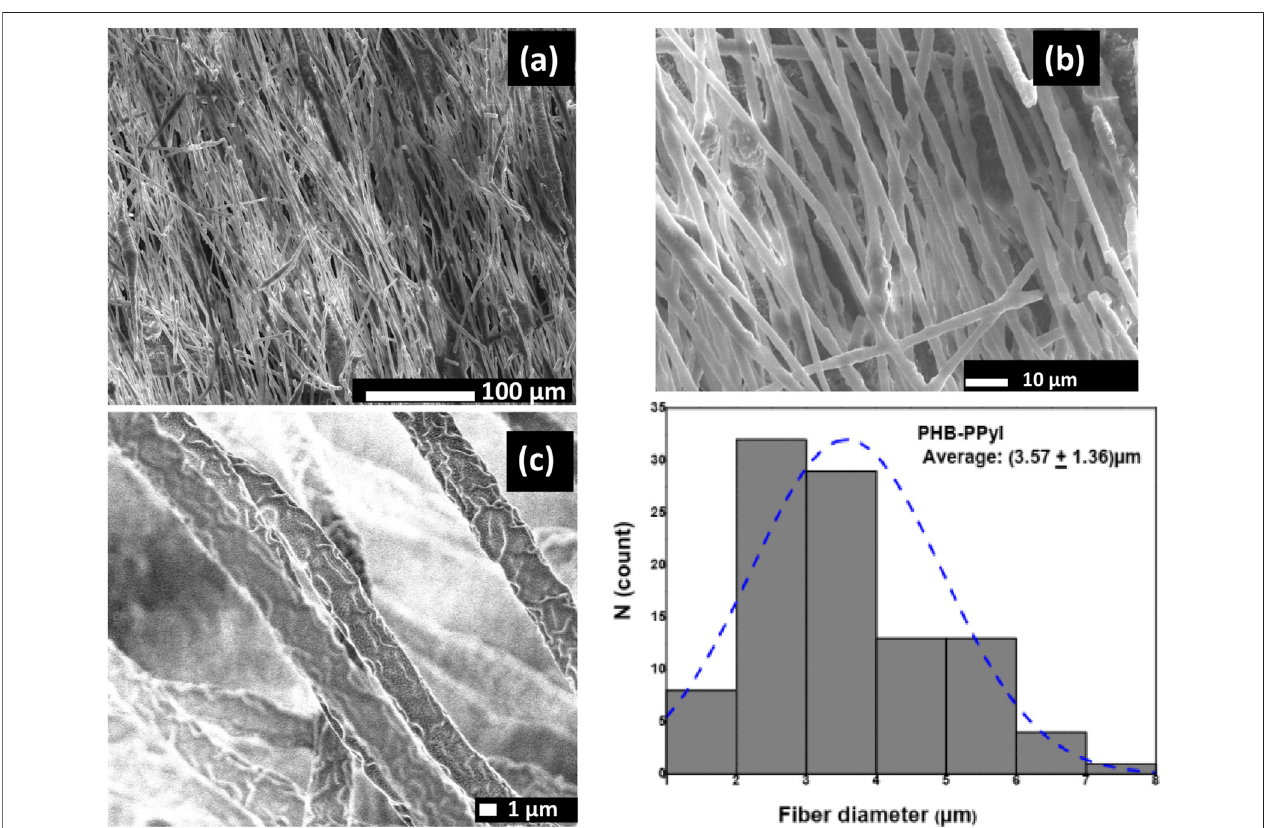
FIGURE 7 | SEM images (A – C) of PHB-PPyI scaffold and (D) fi ber diameter distribution.